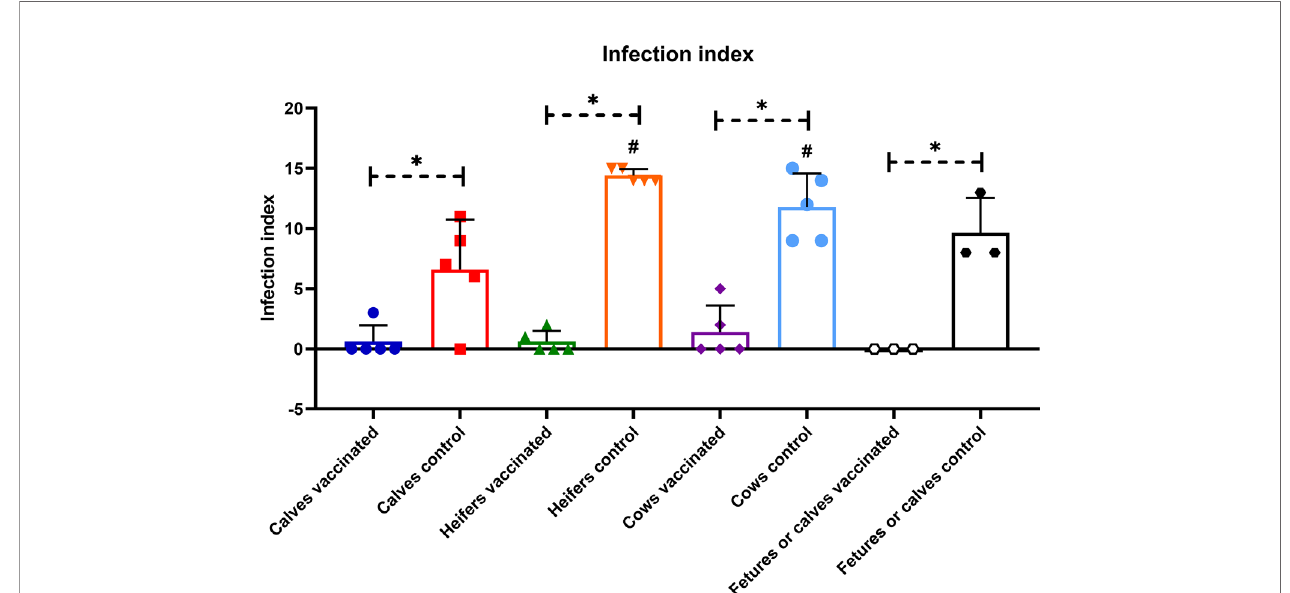
FIGURE 8 | Infection index of calves, heifers, cows, and their calves or aborted fetuses of the experimental and control groups after challenge with B. abortus 544 infection. The calves, heifers and adult cows in the vaccinated group were immunized twice via the subcutaneous route at an interval of 28 days with vaccines generated from the IVV subtypes H5N1 (prime vaccination) and H1N1 (booster vaccination). Animals in the control group were subcutaneously injected with 1.0 ml of 20% Montanide Gel01 adjuvant in PBS. All the animals of the experimental and control groups were subjected to virulent strain B. abortus 544 challenge infection at 28 days after booster vaccination. Infection index — number of organs and lymph nodes of animals in which Brucella were isolated. The data was presented as means with standard errors (SEM). *P = 0.04 – P < 0.0001 vs. appropriate controls; # P = 0.009 – P < 0.0001 vs . calves control. Statistical analysis was performed using two-way ANOVA followed by Tukey ’ s multiple comparisons test. P values < 0.05 were considered signi fi